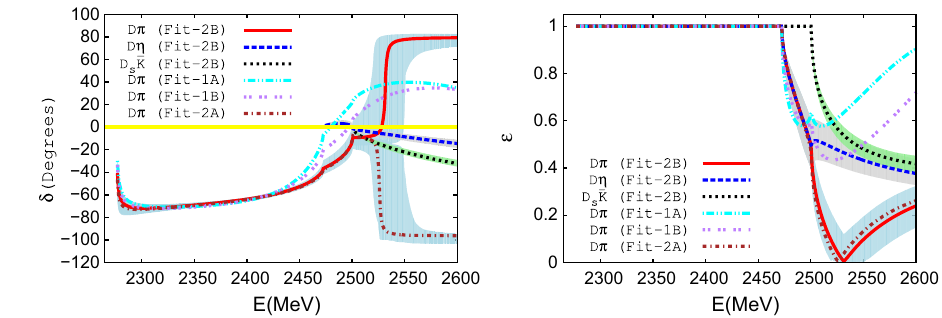
Fig. 5 Phase shifts ( δ ) and inelasticities ( ε ) of the coupled-channel D π, D η and D s ¯ K S -wave scattering with ( S , I ) = ( 0 , 1 / 2 ) obtained at m π = 391 MeV as in Ref. [28]. The red solid, blue dashed and black dotted lines in the left panel denote the phase shifts obtained with the central values from Fit-2B for the D π, D η and D s ¯ K channels,